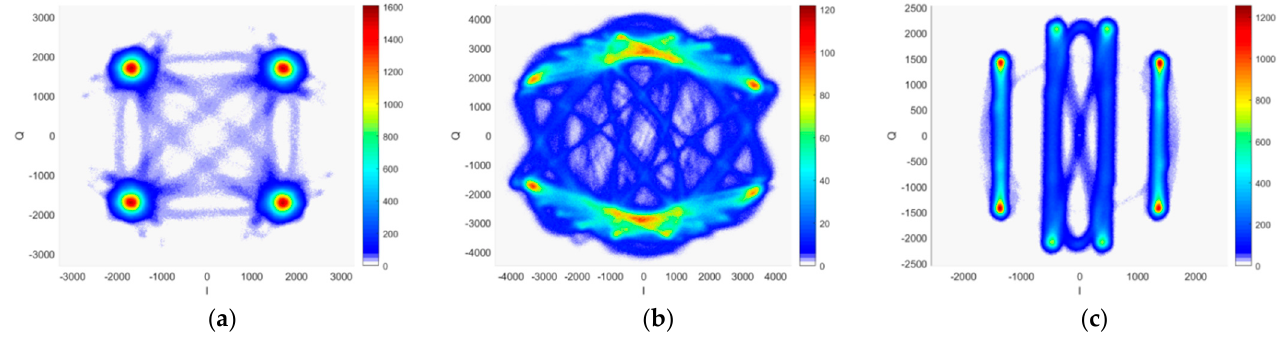
Figure 2. Multiplex signal constellation diagram. ( a ) BPSK signal. ( b ) POCET signal. ( c ) INTERPLEX signal.